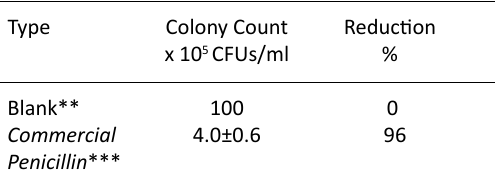
Table 4. Effect of commercial penicillin on colony